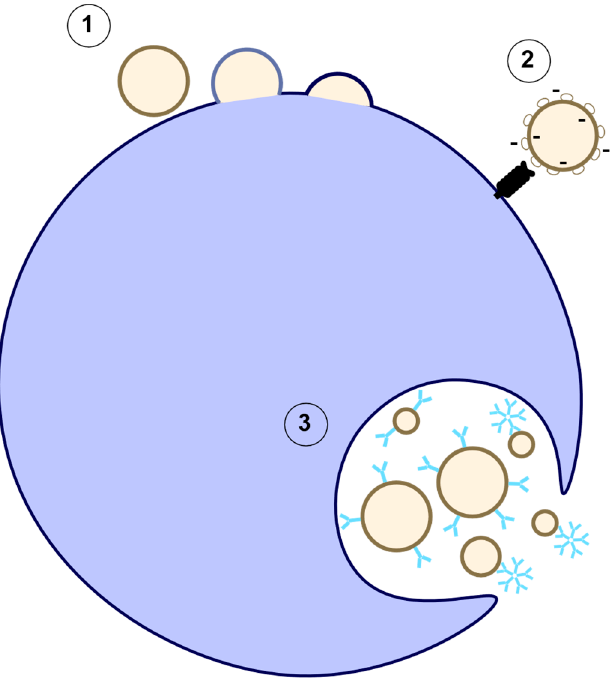
Figure 3. EV Uptake by Cells. EVs can be taken up and cleared from circulation via three methods. (1) The EV membrane can fuse with the plasma membrane of the cell, releasing the EV contents into the cytoplasm. (2) Receptor-mediated endocytosis can occur when a receptor on the cell membrane, such as lactadherin, attaches to a molecule on the EV, such as negatively charged phosphatidylserine. (3) EVs can be endocytosed or phagocytosed. When EVs are coated with molecules like immunoglob- ulins, phagocytosis of the EVs is increased. When coated with IgG, EVs are endocytosed to a greater degree regardless of their size, however, when they are coated with IgM, phagocytosis is preferential for smaller